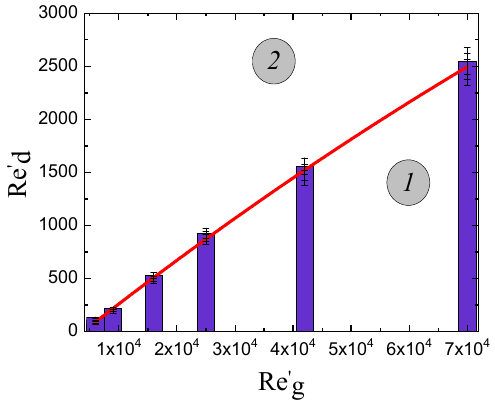
Figure 7. Typical areas of liquid droplet entrainment ( 1 ) by high-temperature gases and its unidirectional movement ( 2 ) [51].